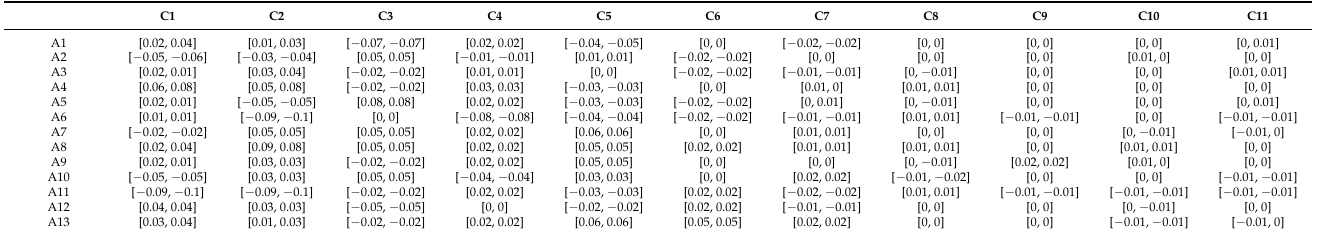
Table 10. Distance matrix of alternatives from border approximate area.